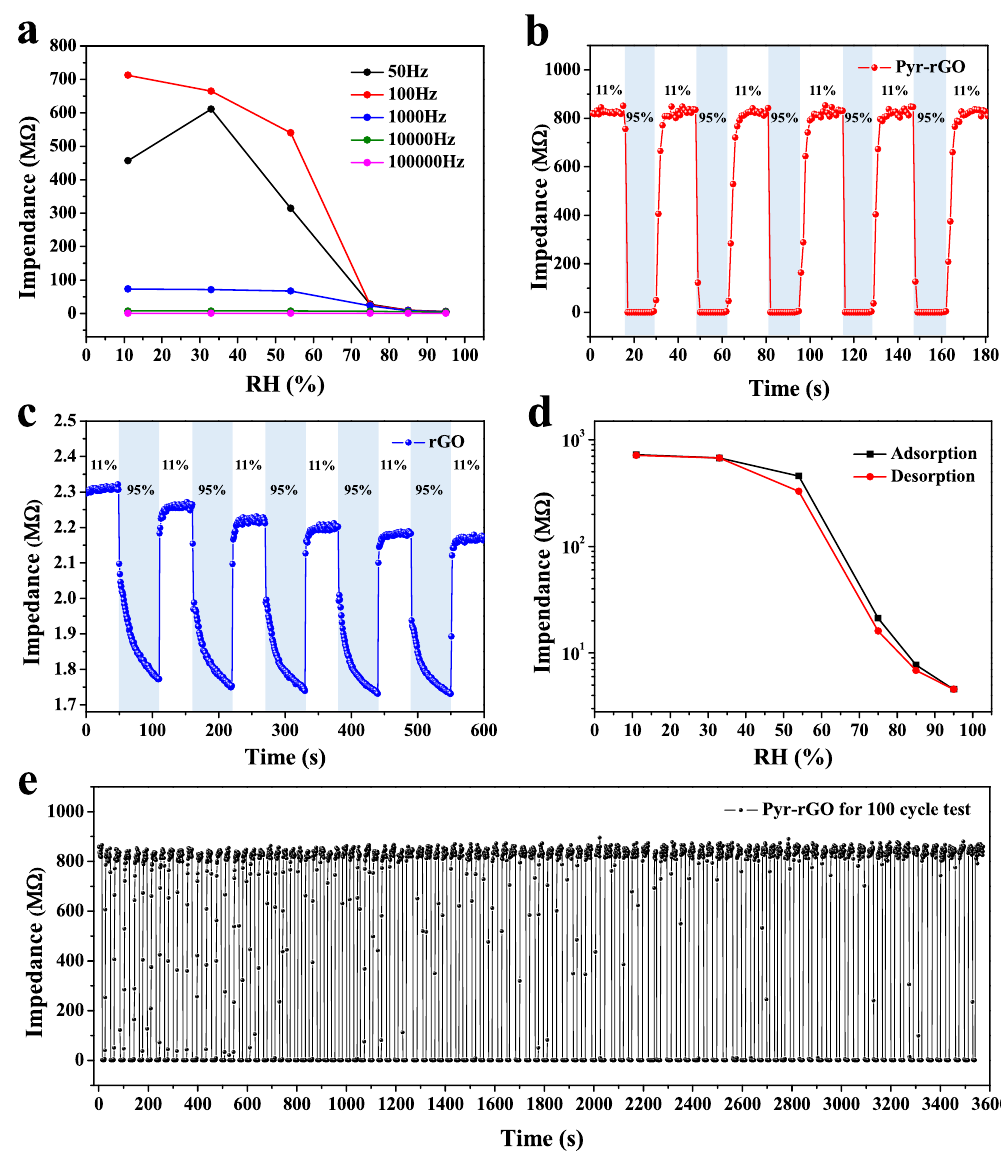
Figure 3. ( a ) The impedance curves of Pyr-rGO based humidity sensors measured at different frequencies under different RH levels. ( b ) The five-cycle response-recovery curve of Pyr-rGO and ( c ) rGO based humidity sensors measured at 100 Hz as RH level alternately changes between 11% and 95%. ( d ) Humidity hysteresis curve of Pyr-rGO based humidity sensors as RH level circularly ranges from 11% to 95% at 100 Hz. ( e ) The 100 cycle continuous response-recovery test for Pyr-rGO based humidity sensors measured at 100 Hz as RH level alternately changes between 11% and